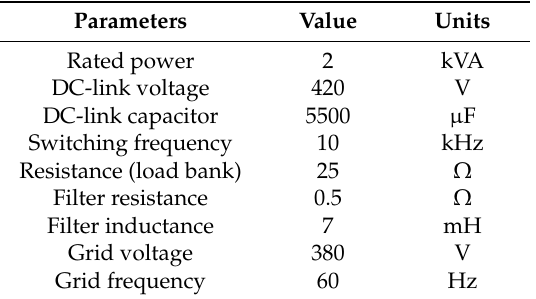
Figure 4. Experimental test setup. Table 1. Specifications of a grid connected inverter.